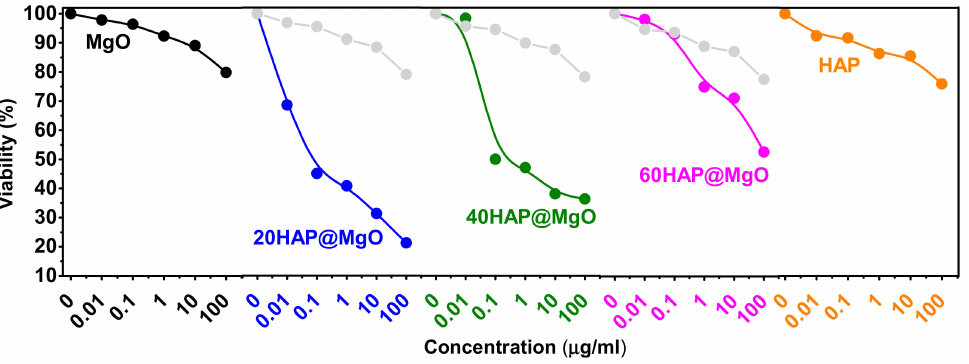
Figure 6. Dose response curves of HAP@MgO composites compared to that of neat MgO and HAP. Grey color curves represents the mathematical (theoretical) values of the composites activity.